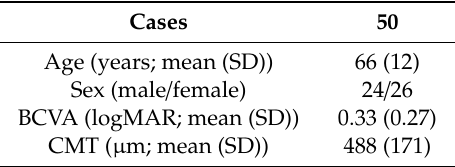
Table 1. Characteristics of enrolled